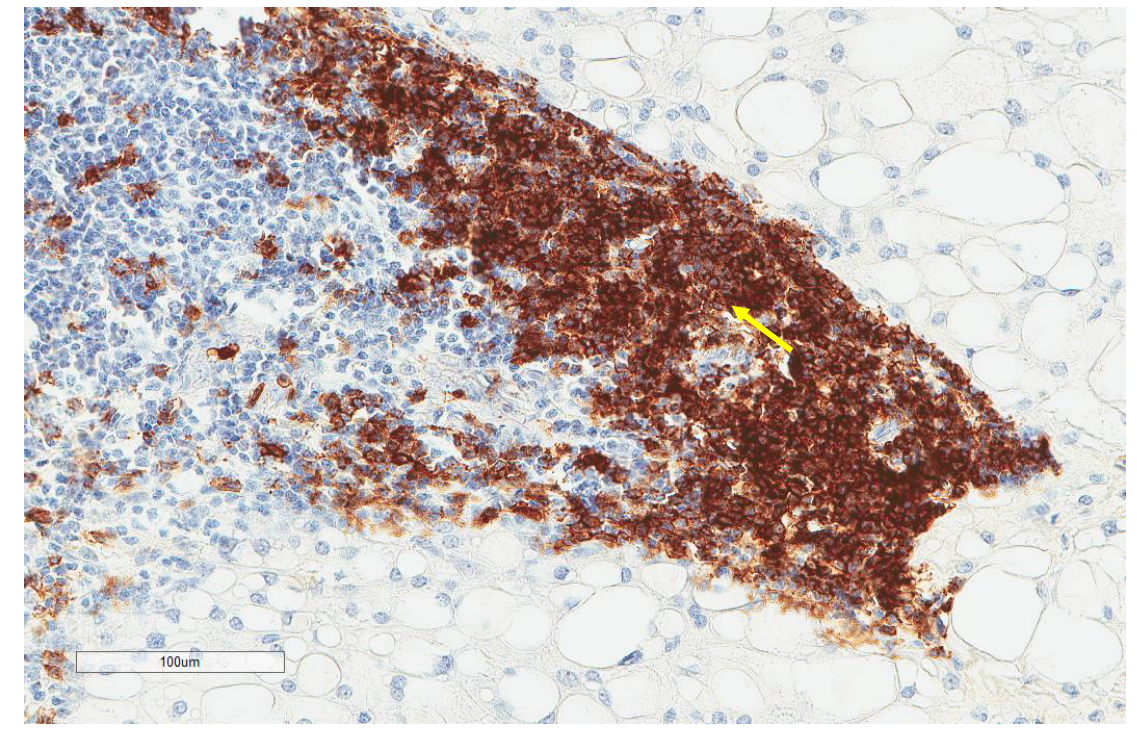
Figure 16. Representative image (same tumor focus as previous image at ×200 magnification) showing CD20+ B cells (yellow arrows).